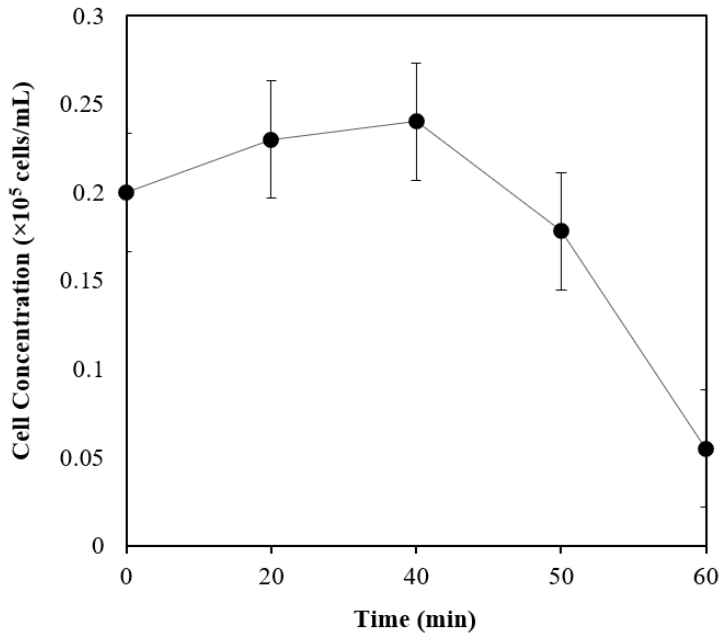
Figure 2. Cell count of EMS-mutated CbCt cells in contact with 15 g/L of Butanol.